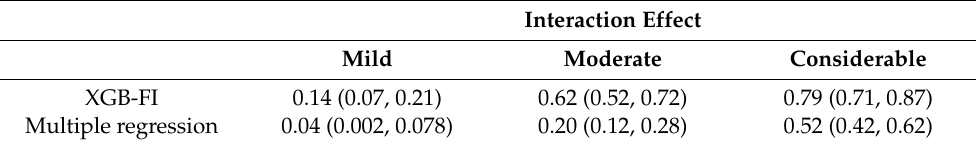
Figure 6. Power simulation under the considerable interaction effect of normal (2, 1) for XGB-FI. Table 2. Power comparisons between the XGB-FI and multiple regression with sample size 500.